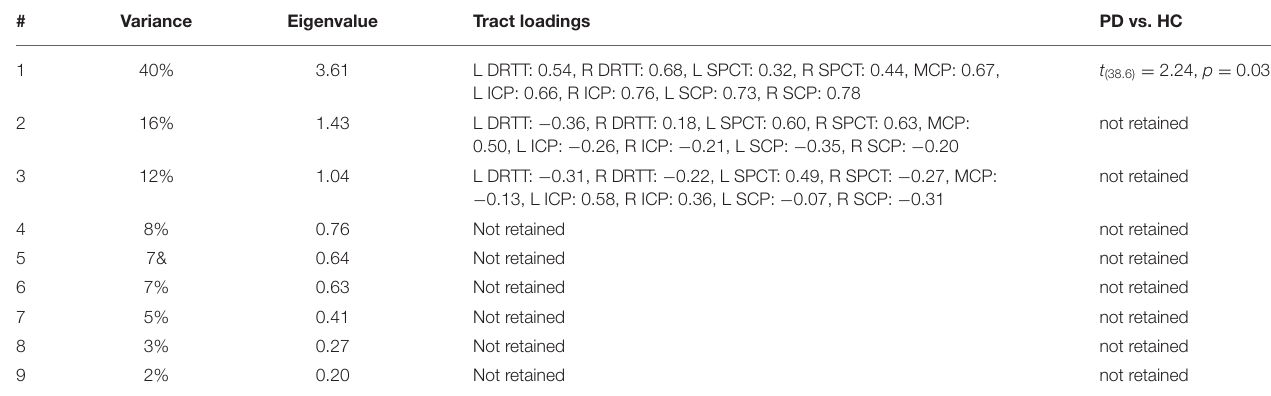
TABLE 2 | Principal component analysis on cerebellar